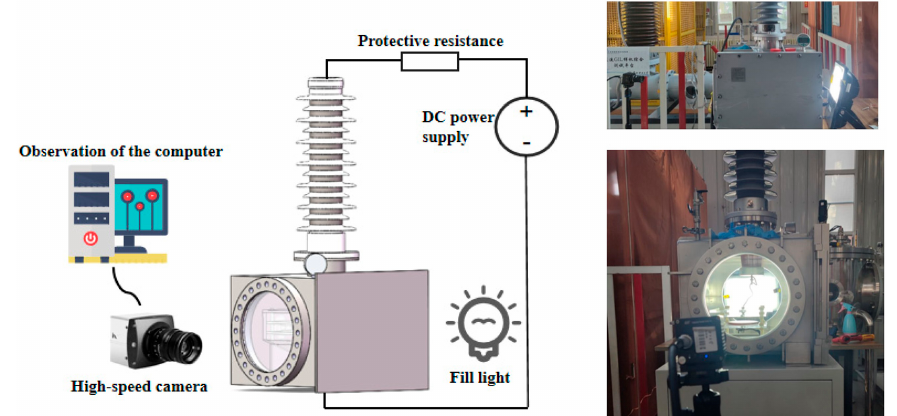
Figure 3. Particle motion observation